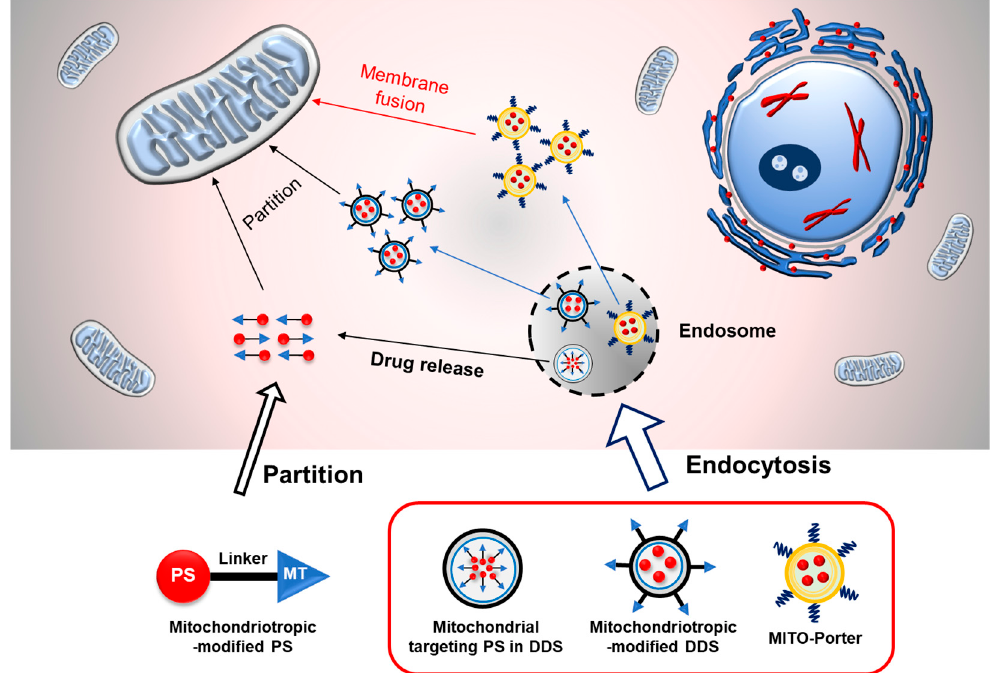
Figure 3. Conceptual illustration of the cellular internalization and mitochondrial delivery mechanism of several strategies in mitochondrial targeting PDT. Mitochondriotropic-modified PS would be taken up by cells through the partition process, while the nanoparticle-based strategy largely results in internalization via the endocytic pathway followed by endosomal escape. Electrostatic interactions with the negatively-charged mitochondria membrane promotes the delivery of the PS to mitochondria by partition or a membrane fusion process.